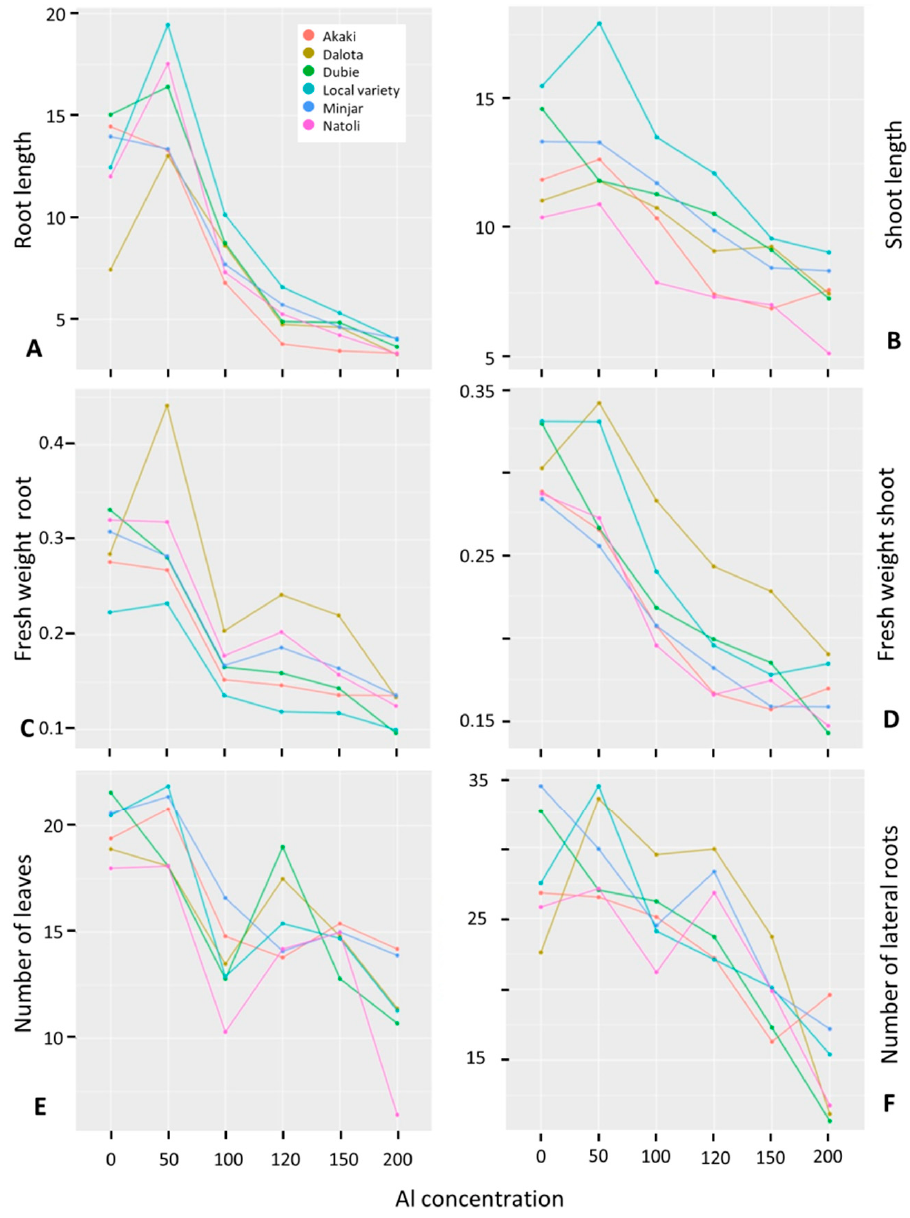
Figure 2. Response of individual chickpea genotypes to increasing Al concentrations. Data represent absolute values of each genotype for each trait. All solutions were at pH 4.5. ( A ) RL—root length (cm); ( B ) SL—shoot length (cm); ( C ) FWR—fresh weight root (g); ( D ) FWS—fresh weight shoot (g); ( E ) NL—number of leaves; ( F ) NLR—number of lateral roots. Table 3. Mean relative root growth of chickpea genotypes for the five Al concentrations (50, 100, 120, 150 and 200) µM relative to 0 µM Al. Relative Root Length Al Concentration